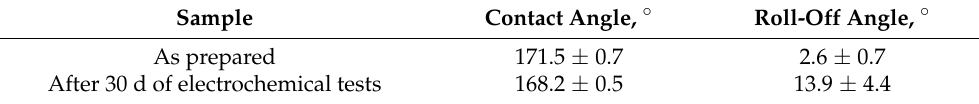
Table 2. The wettability parameters of the superhydrophobic magnesium sample before and after 30 days of electrochemical tests under continuous contact of the sample with 0.5 M aqueous solu- tions of NaCl.